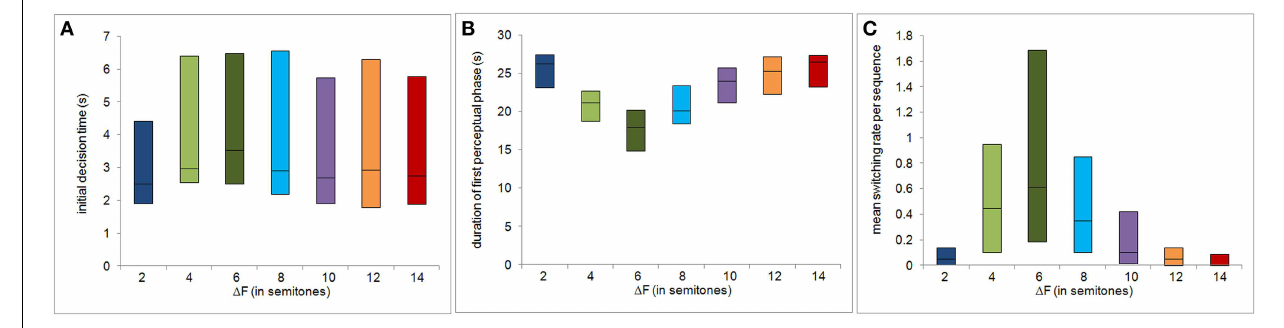
FIGURE 3 | Decision uncertainty and bistability measures as a function of the frequency separation 1 F. The panels show, as functions of 1 F, the initial decision time (A) , the duration of first perceptual phase (B) ,